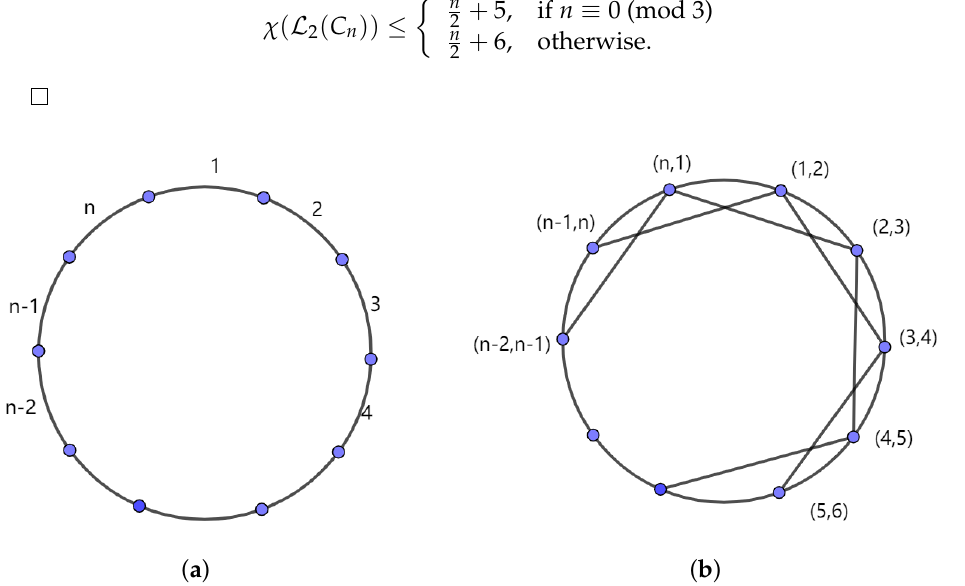
Figure 4. The labeling of edges of C n and L 2 ( C n )[ D ] : ( a ) C n ; ( b ) subgraph of L 2 ( C n ) induced by D . 4.